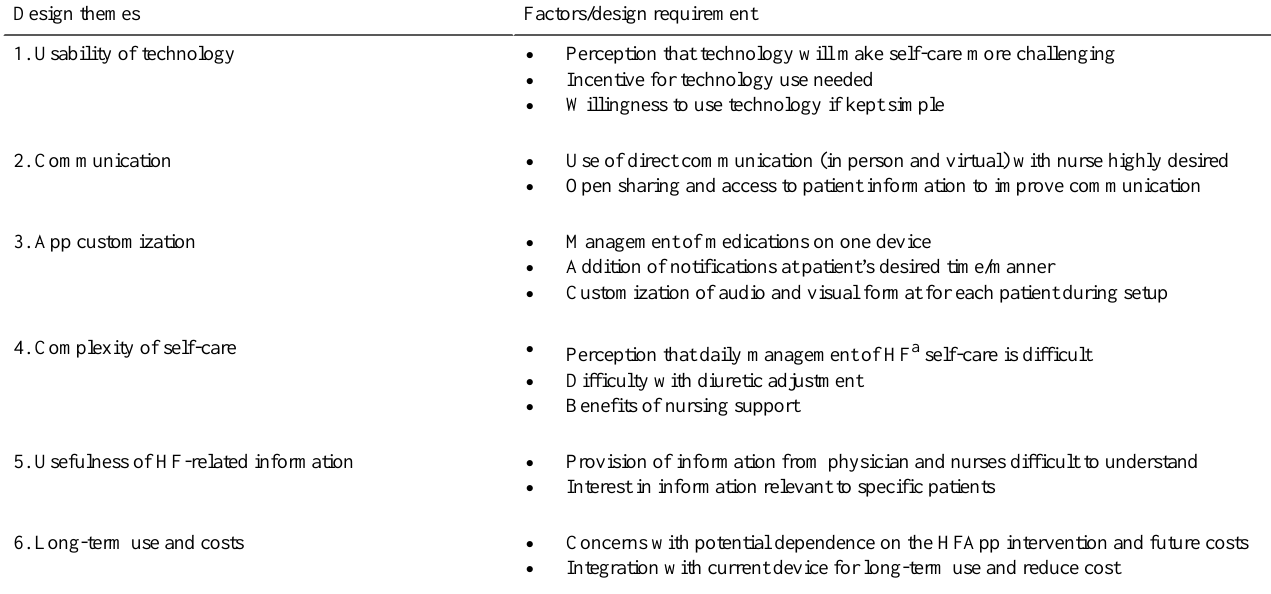
Table 1. Design themes derived from patient and care provider interviews.